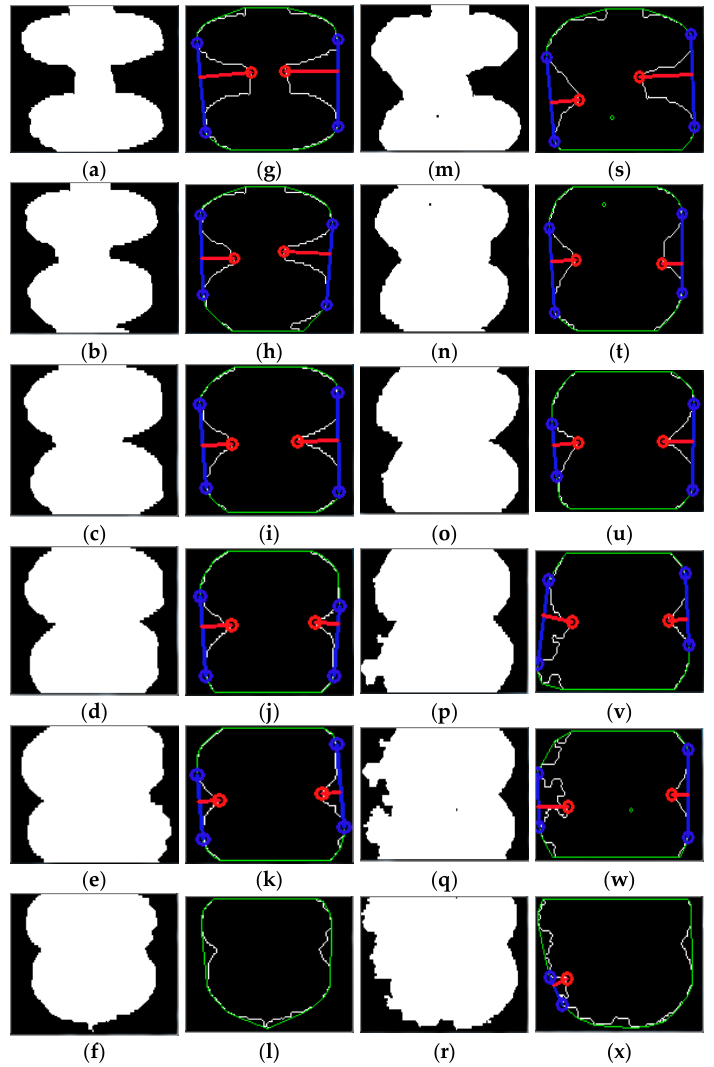
Figure 11. Insulators without ice ( a ) and their convexity hulls and defects of adjacent sheds ( c ), and insulators with ice ( b ) and their convexity hulls and defects of adjacent sheds ( d ) in Group 3.